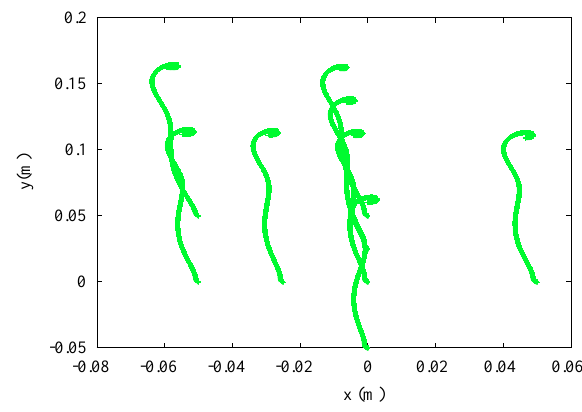
FIG. 14. (Color) Tracking a momentum 1.5 times that shown in Fig. 12 shows some mismatch due to the coupler length.